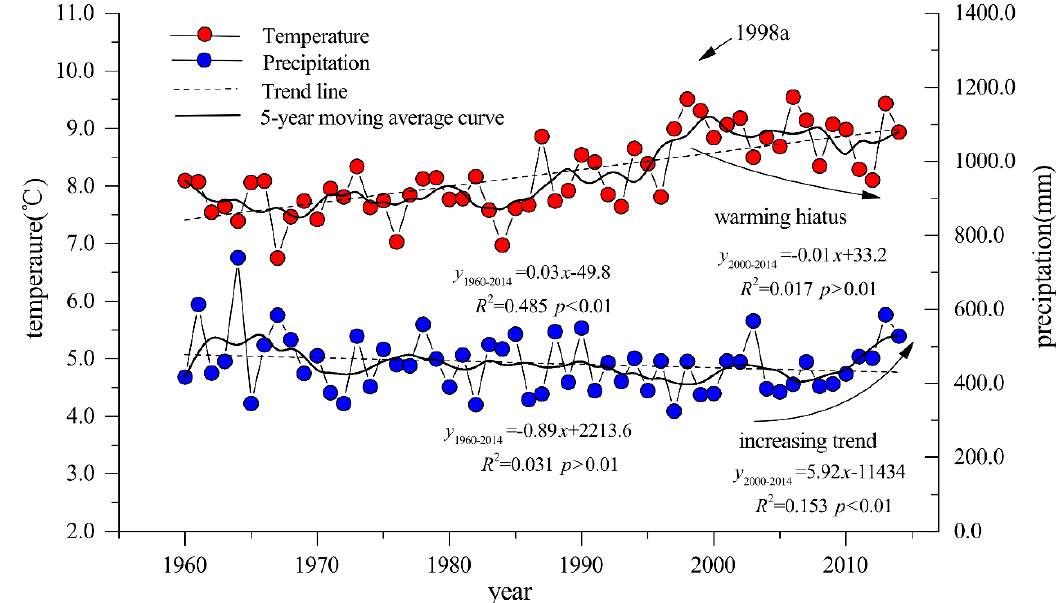
Figure 5. Climate change in the Shaanxi-Gansu-Ningxia region from 1960 to